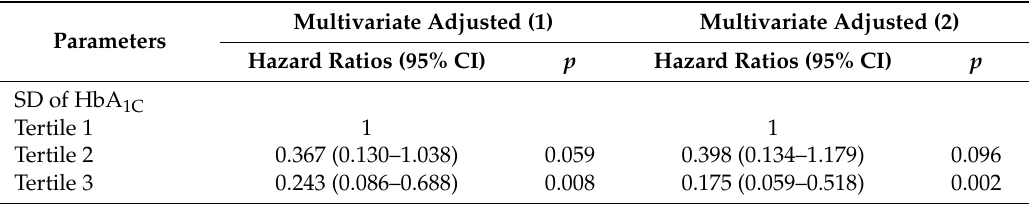
Table 3. Relation of SD tertile of HbA 1C for progression to dialysis using multivariate stepwise Cox proportional hazards model in patients with HbA 1C ≧ 7% and CKD stages 3–4. Multivariate adjusted (1) Multivariate adjusted (2) Parameters